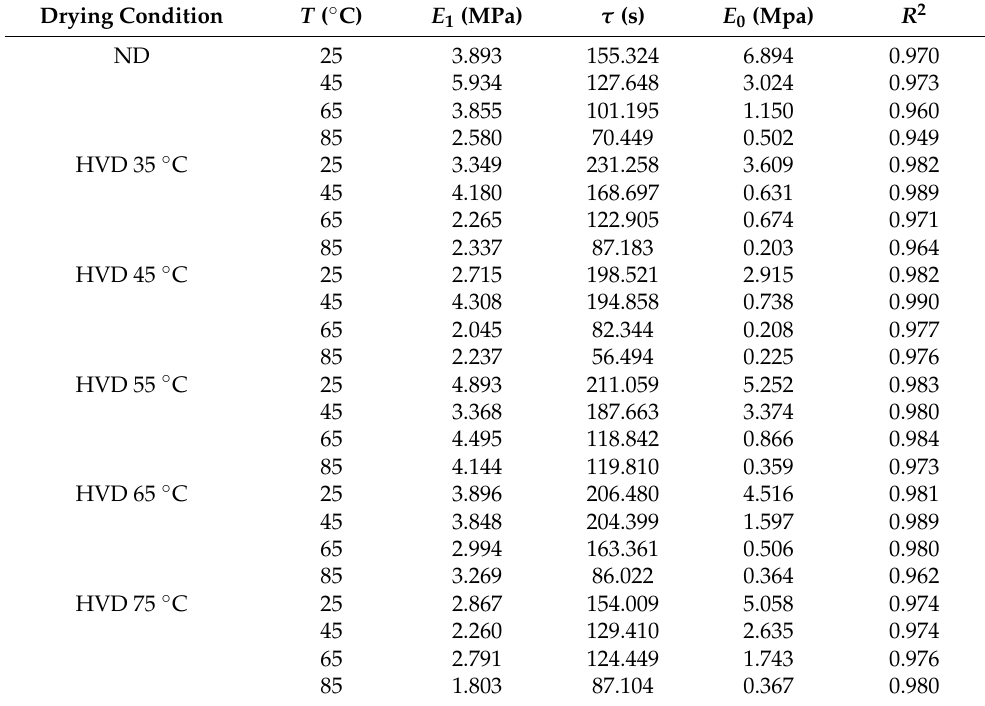
Table 1. Parameters of the generalized Maxwell equation for maize